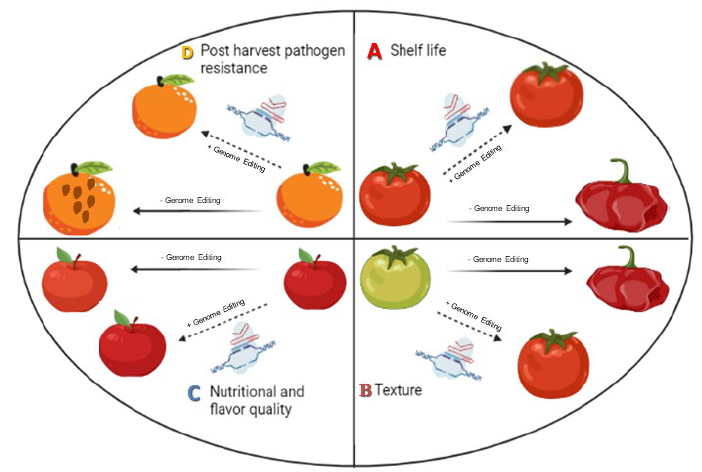
Figure 2. Genome editing tool could enhance various parameters of post-harvest shelf life and quality of horticultural crops in comparison to normal conditions: ( A ) It may extend shelf life and delay ripening without affecting post-harvest quality. ( B ) It may maintain the fruit texture without altering other characters such asfruit size and color. ( C ) Nutritional and flavor quality may be en- hanced without losing post-harvest quality. ( D ) Post-harvest diseases could be overcome.